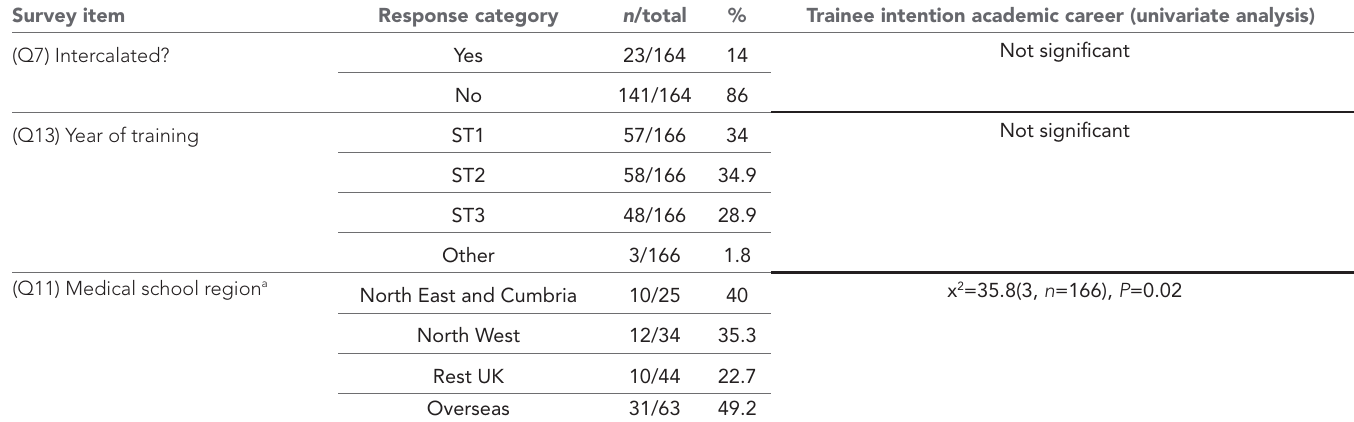
Table 3 Trainee intention to undertake form of academic career (research or education) presented with associations with intercala- tion, year of training, and medical school